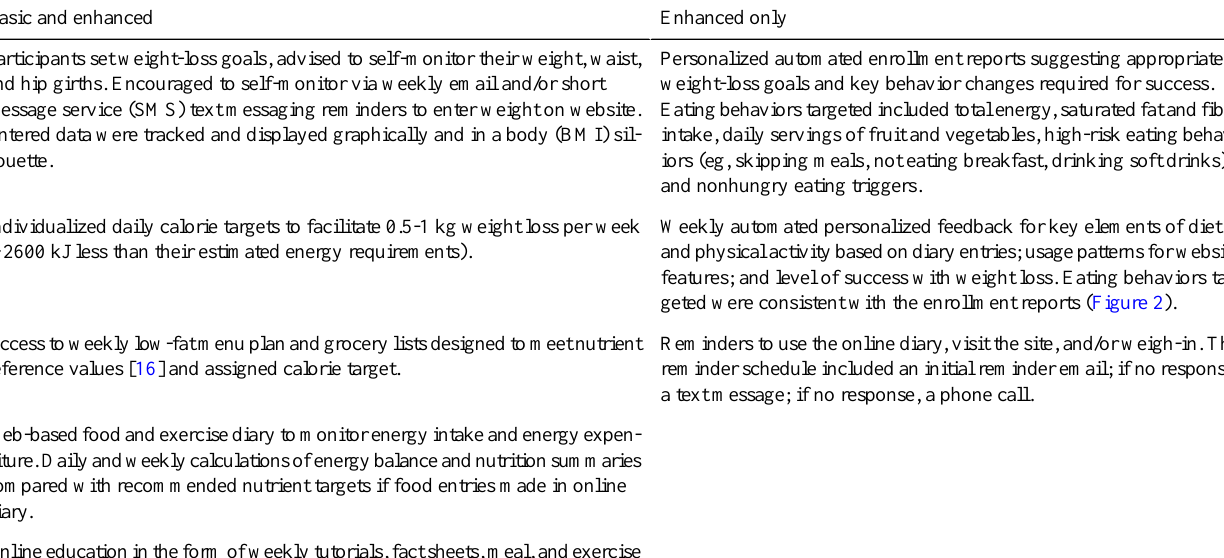
Table 1. Description of the basic and enhanced commercial Web-based weight-loss programs.